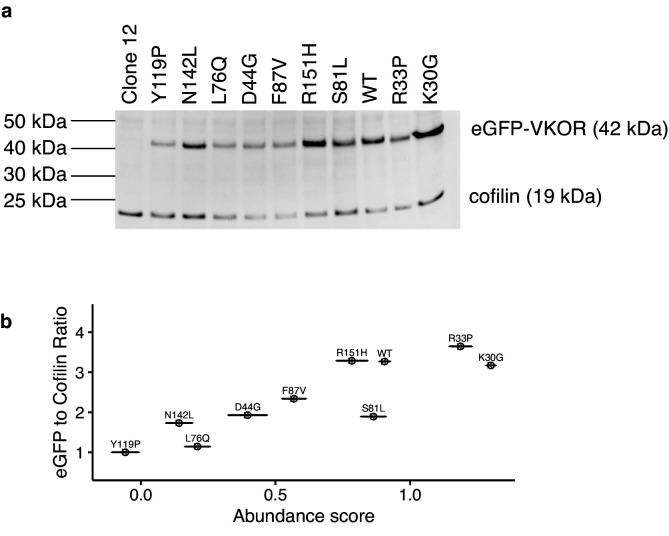
Western blot validation of VKOR abundance scores.(a) Ten variants that spanned the range of abundance scores were assayed individually via Western blot. Protein abundance was measured using a GFP-specific antibody, resulting in a band at ~42 kDa, the predicted size of an eGFP-VKOR fusion. A cofilin-specific antibody was used as the loading control. (b) Ratios of eGFP band intensity to cofilin band intensity from the Western blot were plotted versus the variant’s abundance score (Pearson’s R = 0.87).Figure 1—figure supplement 2—source data 1.Western blot intensity values derived from Figure 1—figure supplement 2a using Image Lab 6.0.1 (Bio-Rad).